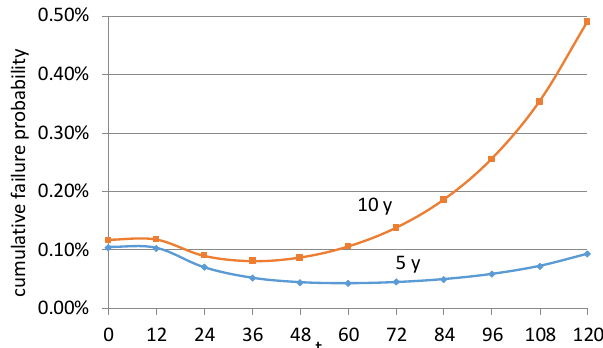
Figure 14. Cumulative failure probability 𝐹 𝑅 (𝑡,𝑡 0 ) of used microcontrollers as a function of time for different values of 𝑡 0 (the life of the component before it is mounted on a new device).